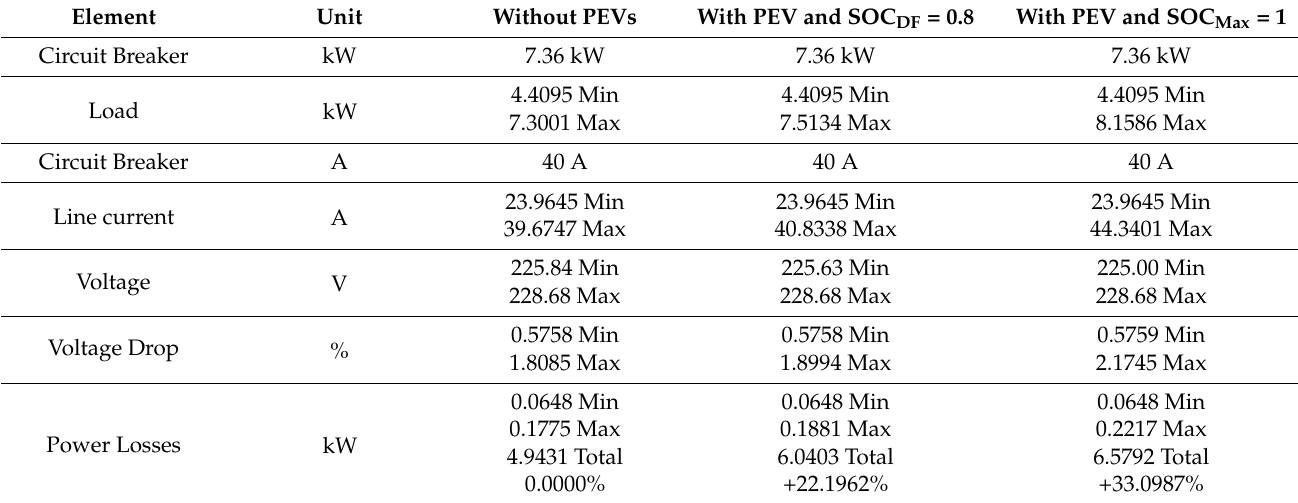
Table 6. Power demand and loss, current and voltage at home